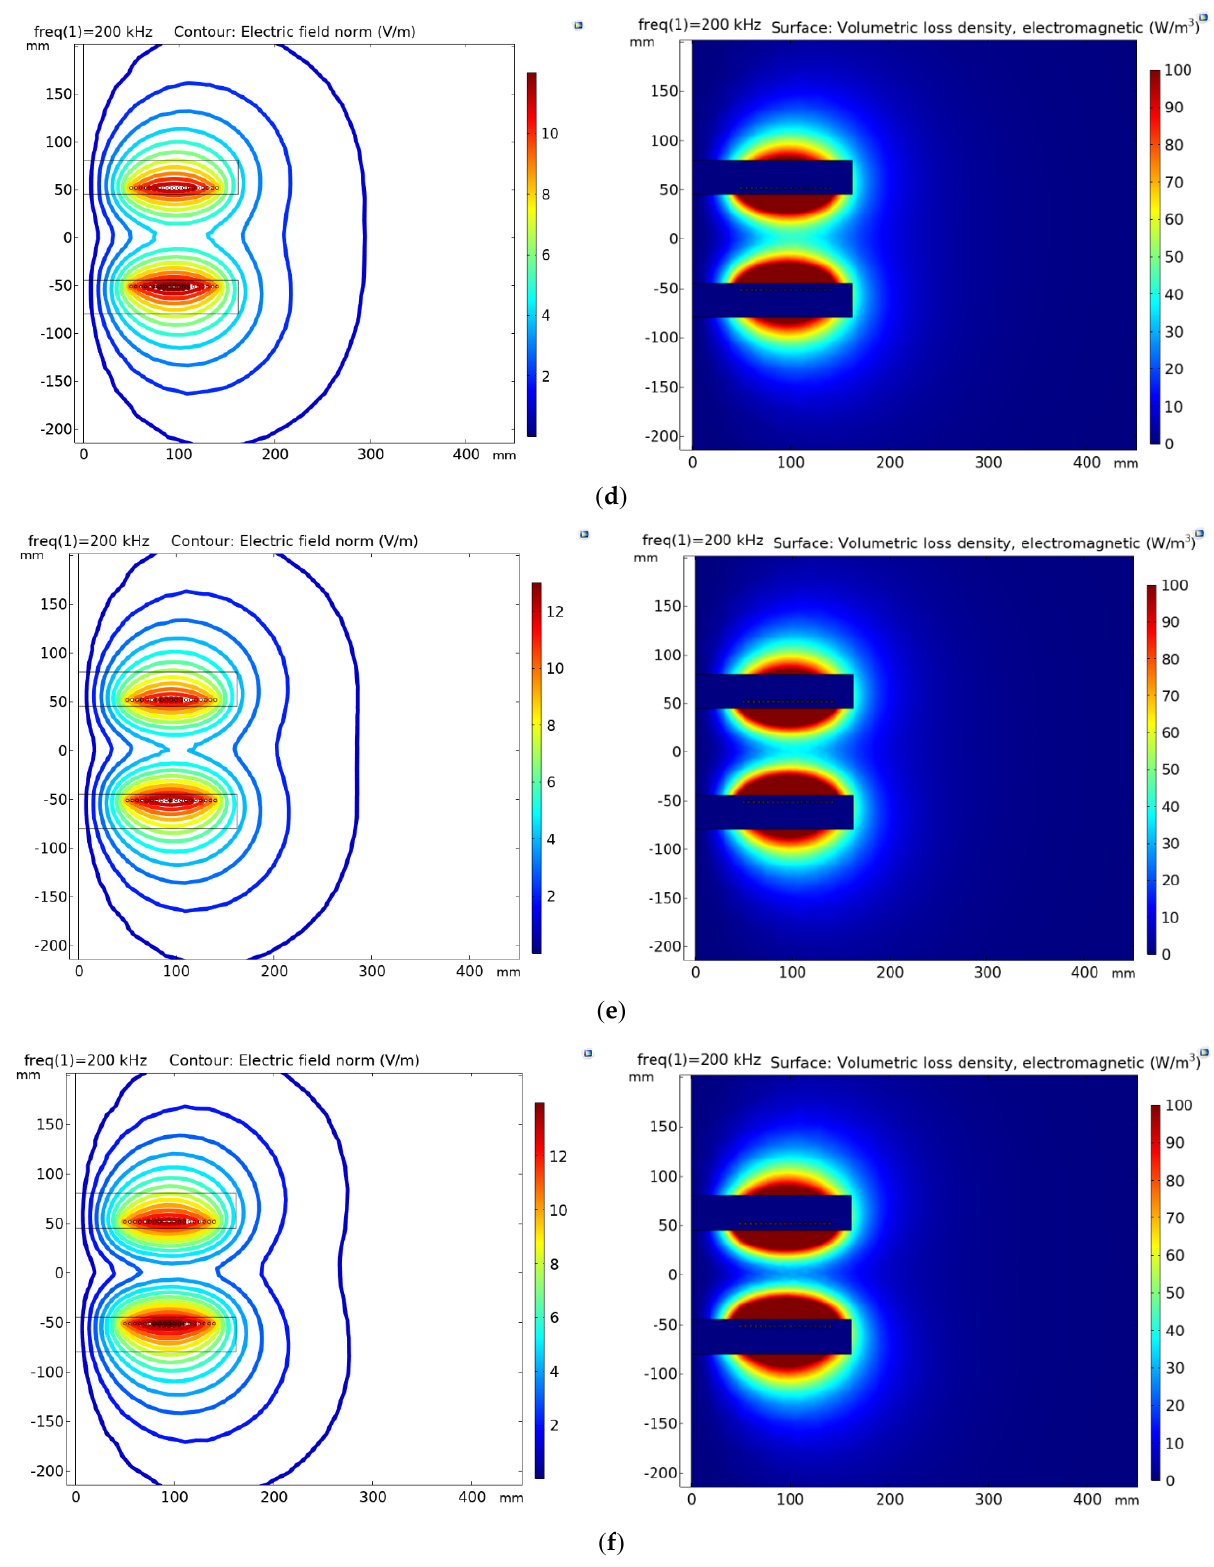
Figure 10. Electric field intensity, energy loss density, and AC-AC efficiency under different phase differences. ( a ) Δ φ = 90.00°, η = 0.8021; ( b ) Δ φ = 110.40°, η = 0.8297; ( c ) Δ φ = 130.80°, η = 0.8435; ( d ) Δ φ = 135.01°, η = 0.8444; ( e ) Δ φ = 140.25°, η = 0.8392; ( f ) Δ φ = 150.02°, η = 0.8145.